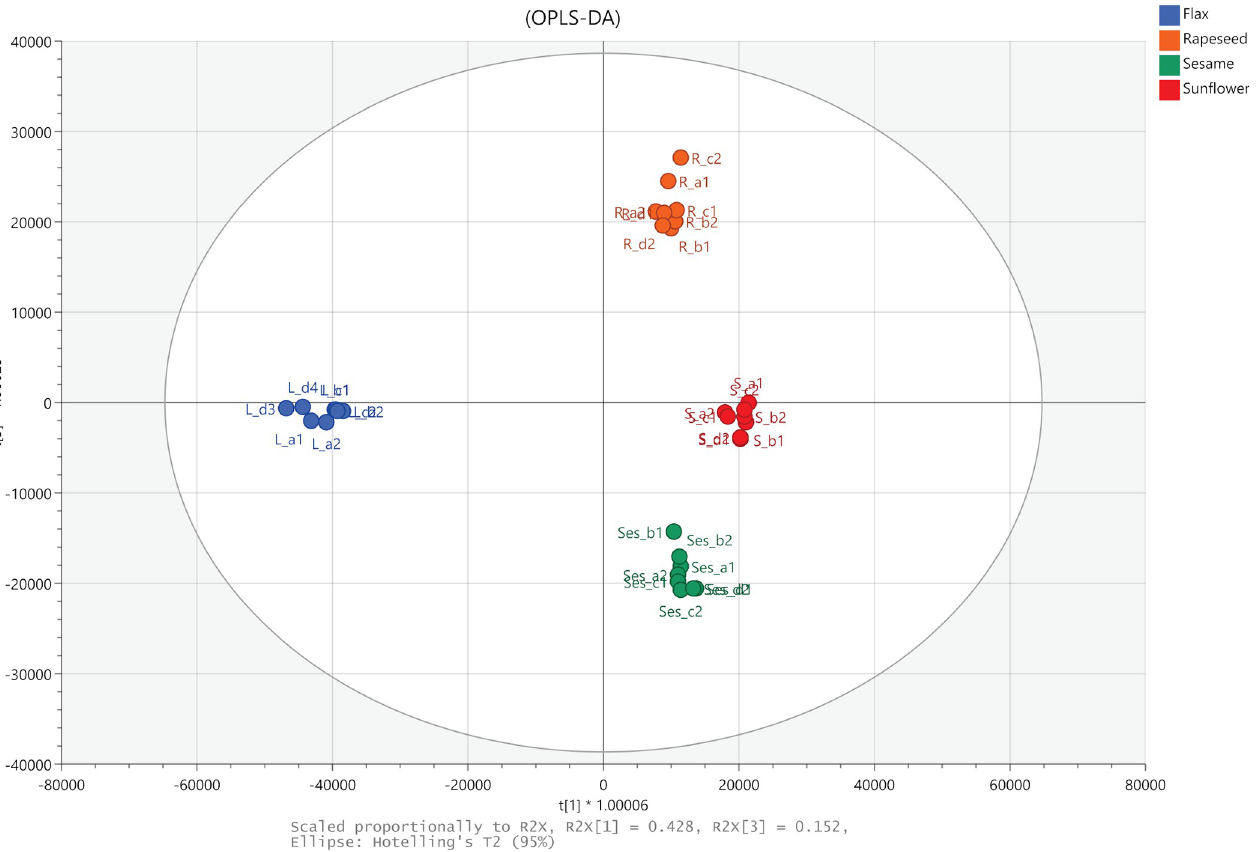
Fig 1. Differentiation of four seed oils based on metabolomics profiles. OPL-DA t[1]-t[3] score plot. Model R2X = 0.878, R2Y = 0.99, and Q2 = 0.981; R2X [1] = 0.428, R2X[2] = 0.223, R2X[3] = 0.152.